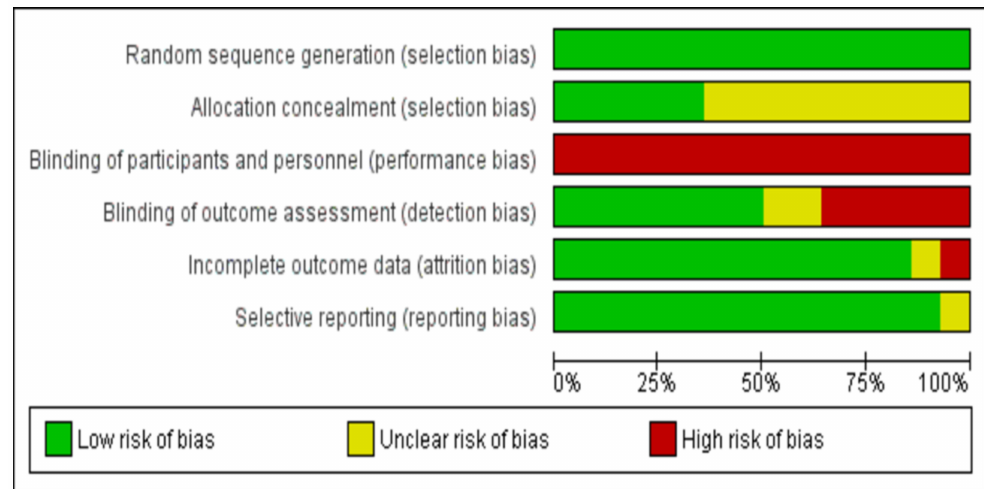
Figure 3. Risk of bias